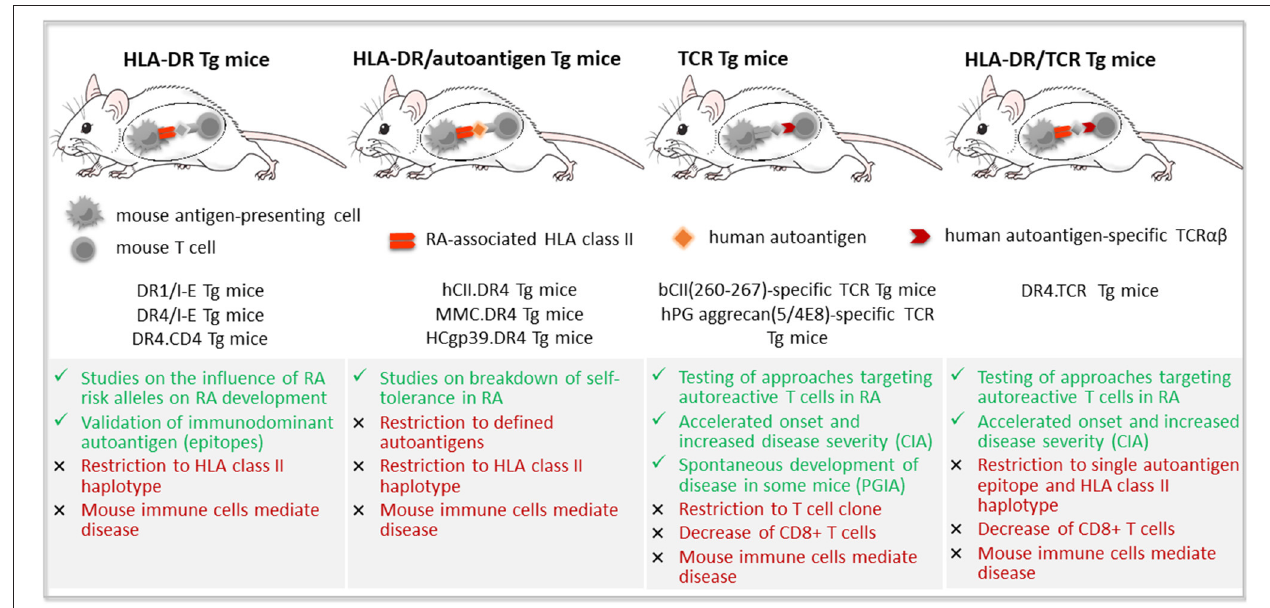
FIGURE 2 | Transgenic mouse models of rheumatoid arthritis. Transgenic (Tg) mouse models of rheumatoid arthritis (RA) reported in the literature include mice expressing (i) RA-susceptible human leukocyte antigen (HLA) class II molecules, such as DRB1*0101 (DR1) or DRB1*0401 (DR4); (ii) human RA-associated autoantigens, such as type II collagen (CII), either complete or as mutated mouse collagen (MMC) containing the immunodominant epitope, and human cartilage glycoprotein-39 (HCgp-39); (iii) an autoantigen-specific T cell receptor (TCR) alone; or (iv) together with RA-susceptible HLA-DR molecules. Advantages are depicted in green color, limitations in